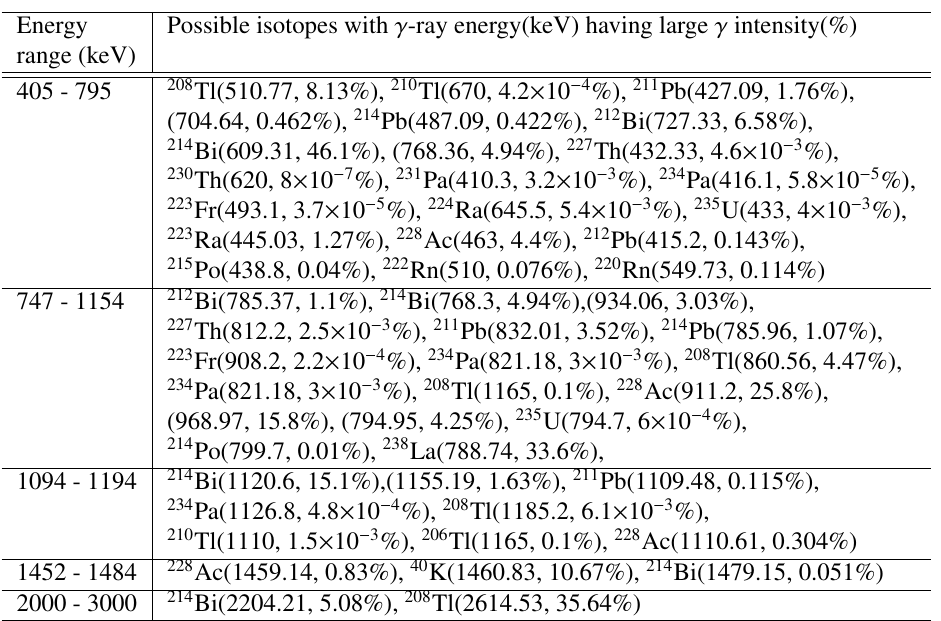
Table 1. The contribution of background γ -ray energy spectrum from the possible isotopes of su ffi cient relative γ